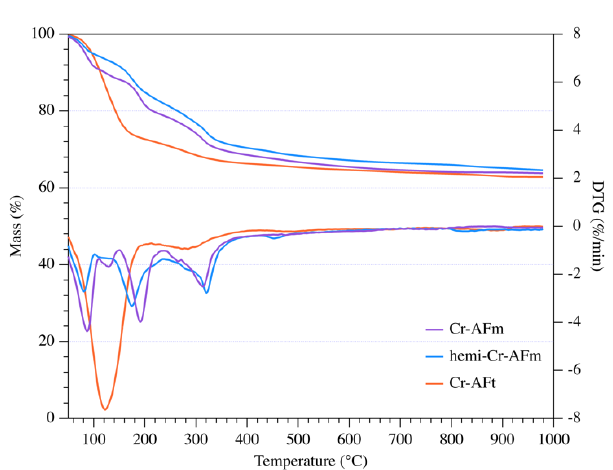
Figure A1. Thermogravimetric analysis of the synthesized samples shown as mass-loss and differential curves and obtained on a NETZSCH TG 209 Libra instrument.